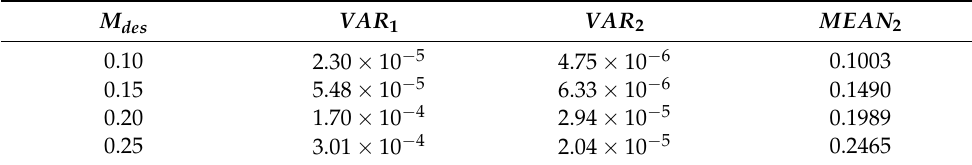
Figure 8. The original images from the test image set. Table 4. The statistical data for the test image